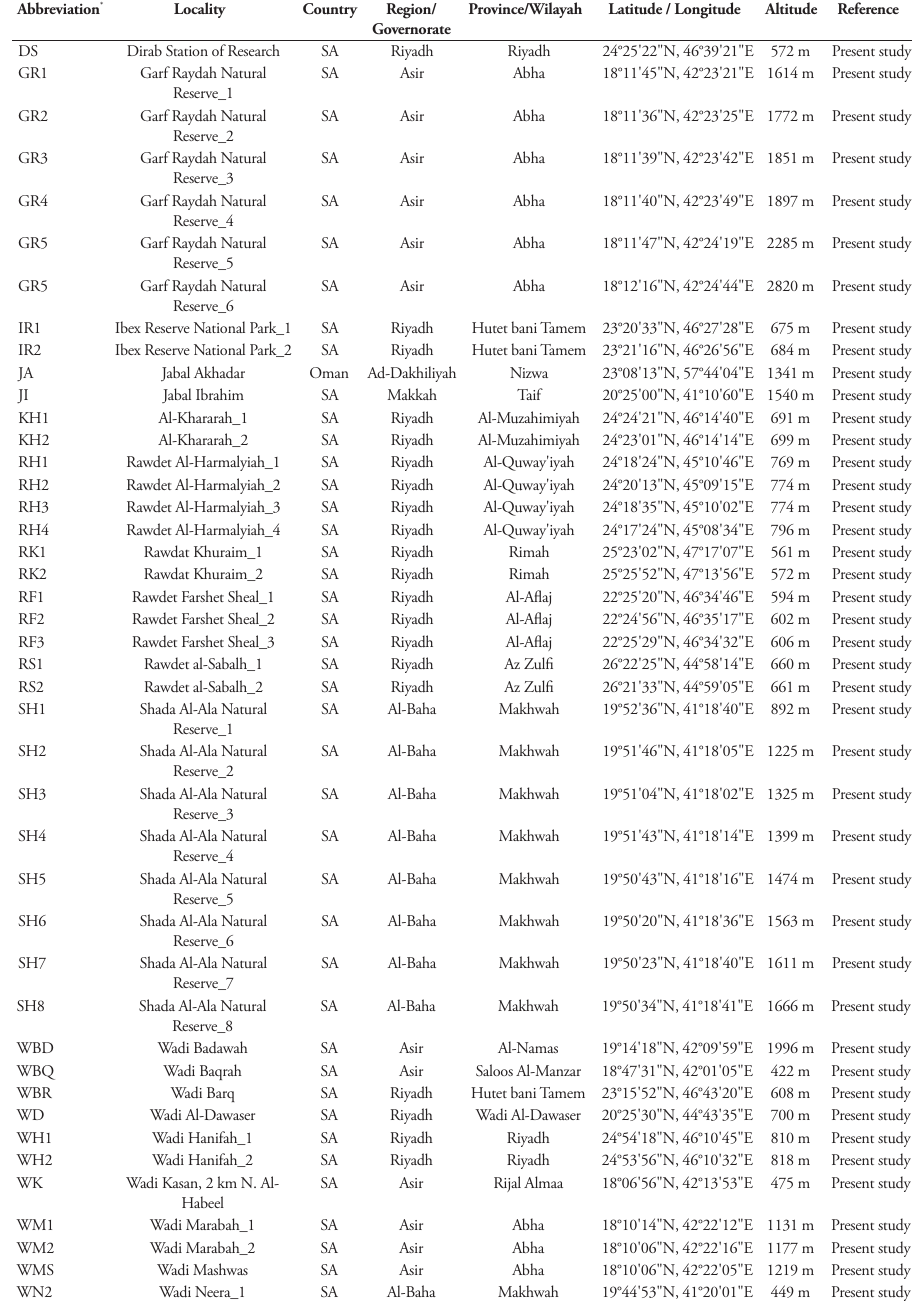
Table 1. Data of sampling localities of Pseudophotopsis species in the Arabian Peninsula during present and previous studies (SA = Saudi Arabia; * = collecting date gathered from previous